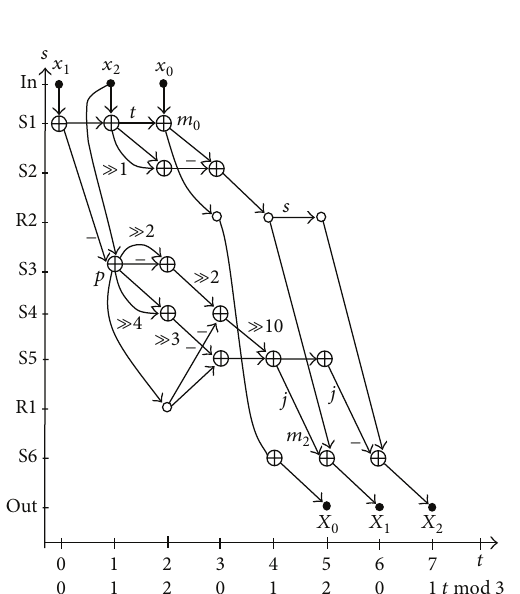
Figure 2: Spatial SDF of the 3-point DFT.